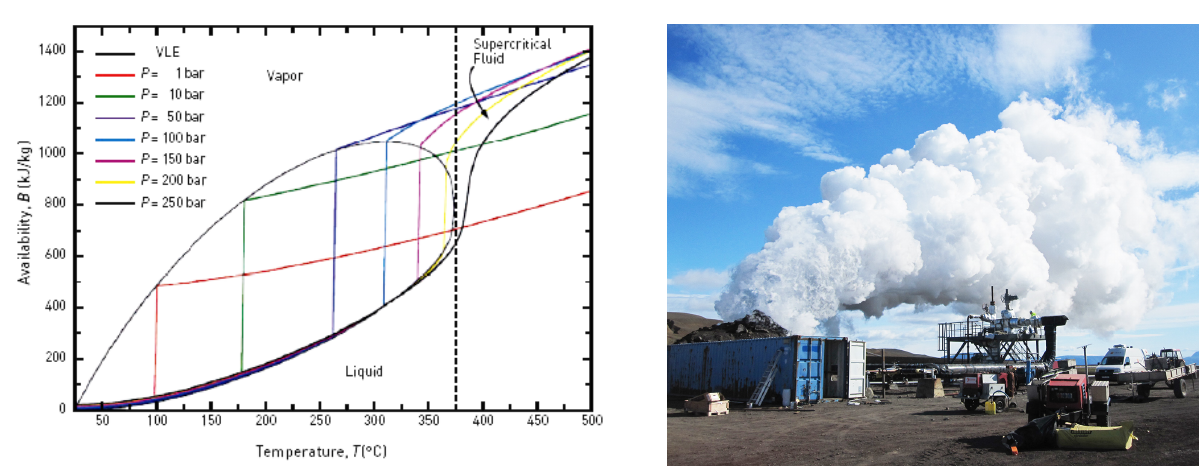
Figure 3. The flow of the IDDP-01 into a rock muffler produced dry superheated steam with only 0.1–0.2% of non-condensable gases. Initially corrosion products gave the steam a dark color, but after a few minutes it became clear and transparent. The condensate had a pH of 2.5–3 due to its HCL content. However, experiments on wet scrubbing to remove acid gases from the dry steam were very successful (Hauksson et al., 2014) (photograph courtesy of Kristján